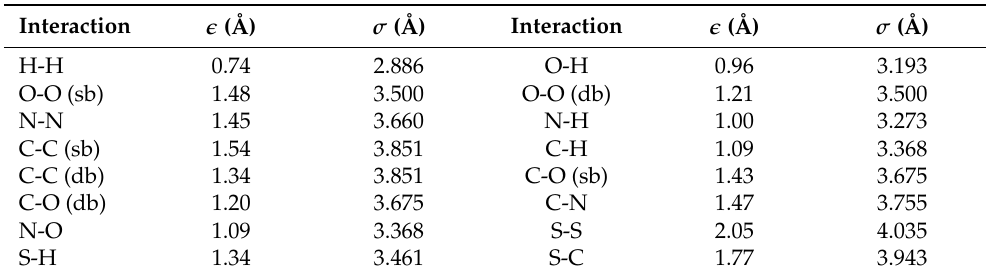
Table 1. The Lennard–Jones constants ( (cid:101) : bond length; σ : non-bond distance; single bond:sb, and double bond:db) [28].